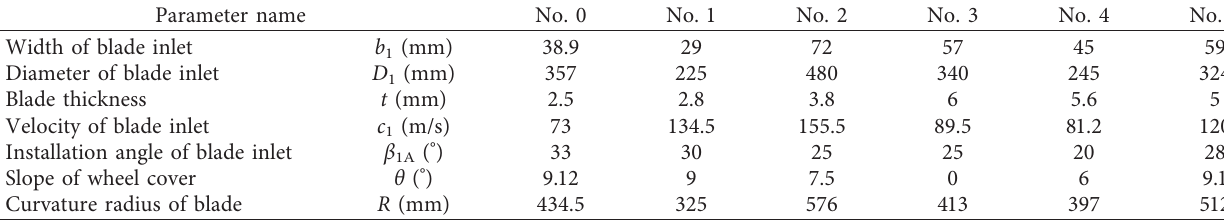
Table 2: Design parameters of the reference impeller.